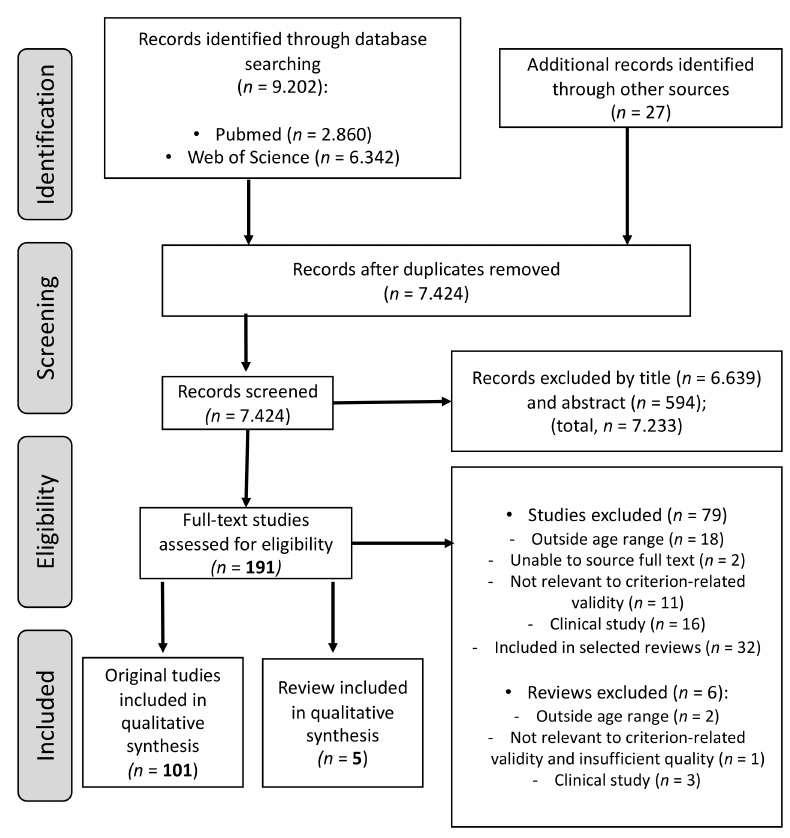
Figure 1. Flow chart of retrieved and selected articles.